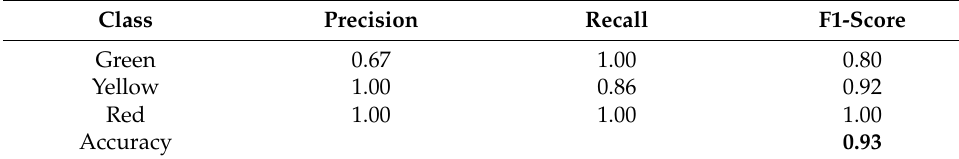
Table 5. Classification report for the XGBoost classifier.